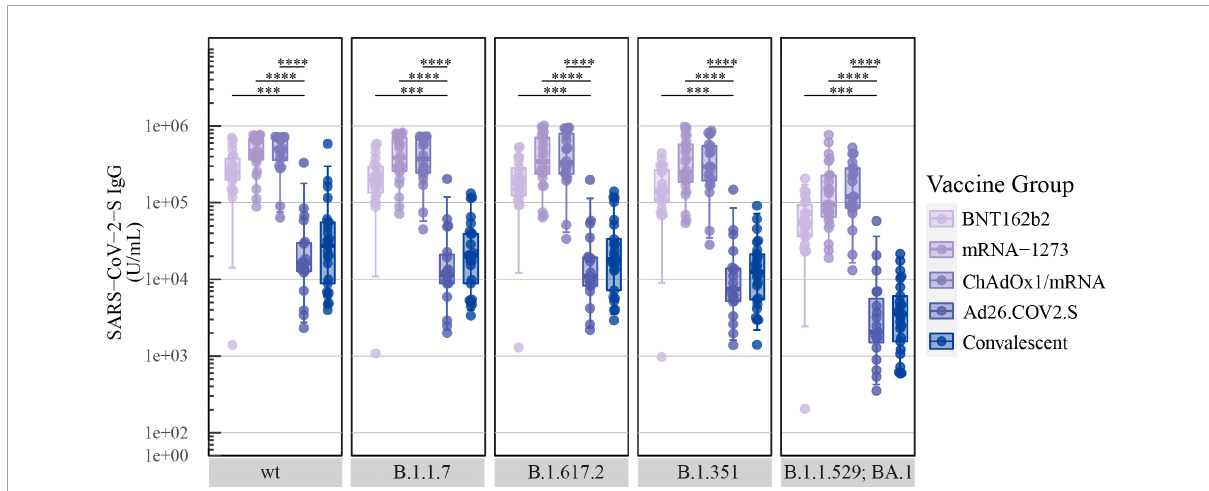
FIGURE1 Levels of SARS-CoV-2-S IgG after COVID-19 vaccination: Levels of total SARS-CoV-2-S IgG in U/mL induced by primary COVID-19 vaccination with BNT162b2 ( n = 22), mRNA-1273 ( n = 24), ChAdOx1/mRNA ( n = 20) or Ad26.COV2.S ( n = 19) quantified by the MSD platform (serum 1:5,000). Data from convalescent comparators ( n = 25) are also displayed, but are not included in the statistical analysis. From left to right: SARS-CoV-2-S wt (Wuhan-Hu-1) and the following SARS-CoV-2-S VOCs: B.1.1.7 (Alpha), B.1.617.2 (Delta), B.1.351 (Beta) and B.1.1.529; BA.1 (Omicron). The boxplots present the lower quartile, median and upper quartile, and the error bars indicate 95% CI. P -values were indicated as follows: ∗∗∗ p < 0.001 and ∗∗∗∗ p <